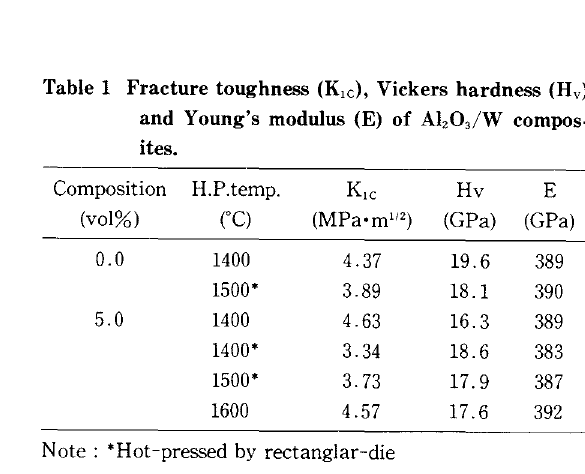
and Young's modulus (E) of Al